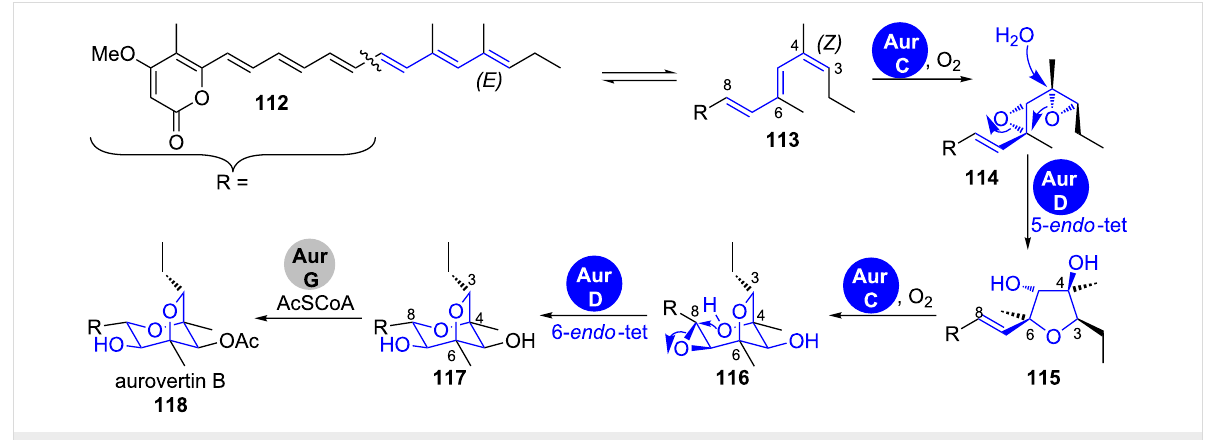
C4 to give the pyran ring. This terminal 6- endo -tet cyclisation is likewise facilitated by AurD, overriding the 5- exo -tet pathway that should be favoured in spontaneous reaction according to Baldwin’s rules. Density functional theory calculations sug- gested that this reaction pathway is favoured, if the hydroxy- epoxide 116 is simultaneously activated by acidic and basic residues